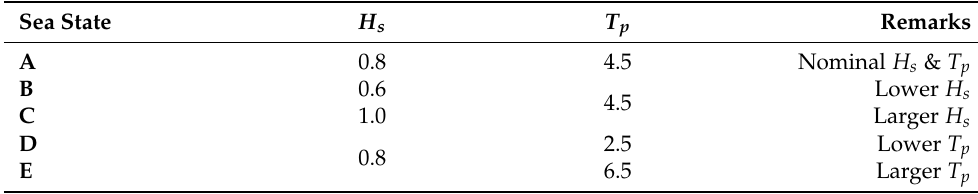
Table 1. The characteristics of five different irregular wave profiles.